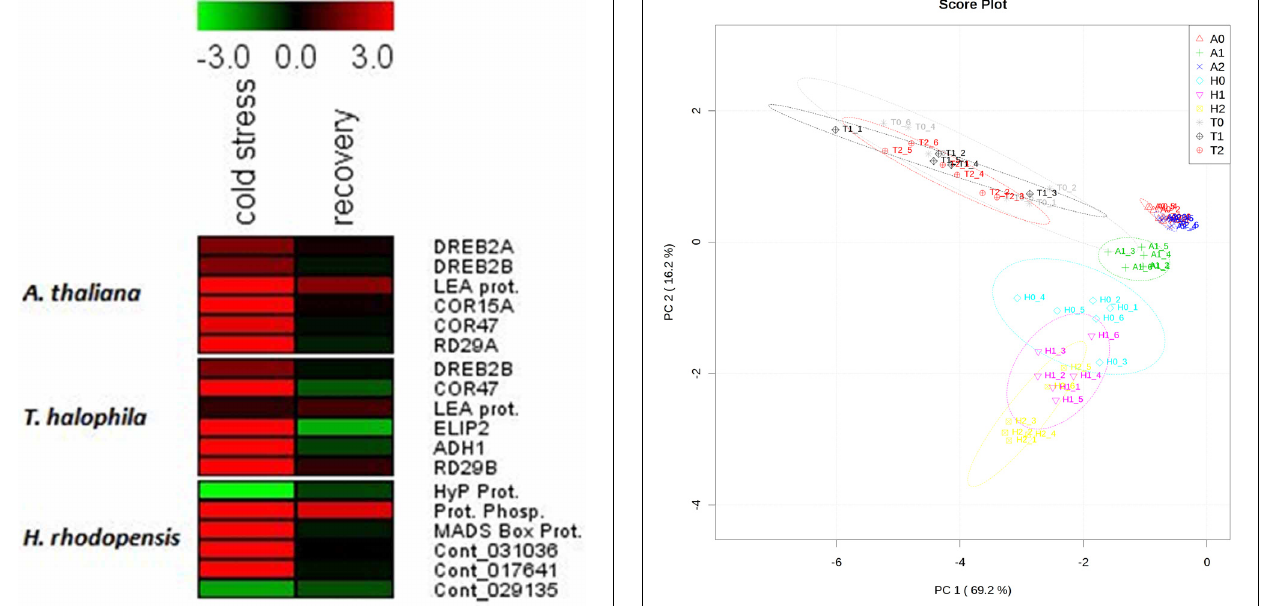
FIGURE 2 | Drought- and cold-responsive genes are induced by the low temperature treatment in A. thaliana, H. rhodopensis , and T. halophila . Plants grown at optimal conditions at 21 ◦ C, 40 μ mol. m − 2 s − 2 light intensity, 16/8 light/dark photoperiod, and relative humidity 70%, were subjected to chilling (4 ◦ C) for 3 days and then returned to 21 ◦ C for recovery. Fully hydrated plants grown at 21 ◦ C were used as a reference point for the qRT-PCT analysis. Red colors and positive values depict induced genes while green colors and negative values depict repressed genes. The data are log ratios, average means of two replicates. The genes and primer combinations used are given in Supplemental Table 1, while the exact values of induction/repression are given in Supplemental Table 2.